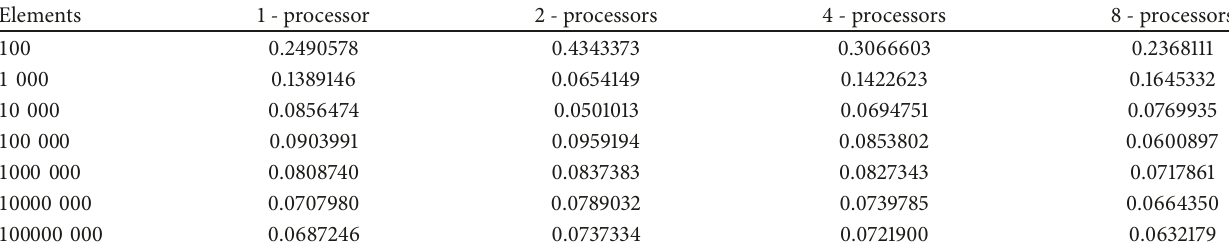
Table 4: Coefficient of variation for sorting operations